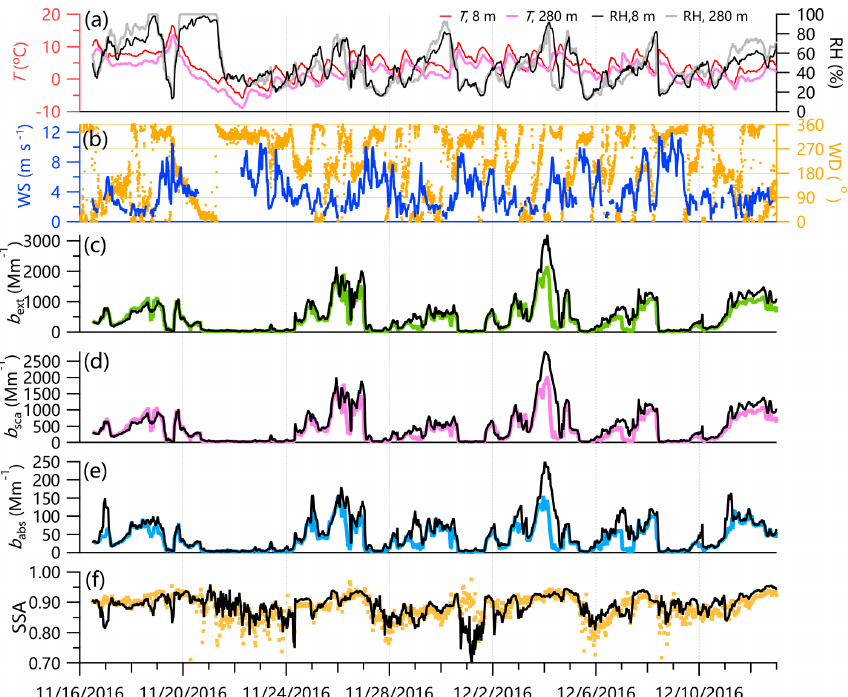
Figure 3. Temporal variations of (a) temperature ( T ) and relative humidity (RH) at ground level and 280m, (b) wind speed (WS) and wind direction (WD) at 280m, and comparisons of the time series of optical properties of PM 2 . 5 between ground level (black lines) and 260m (colored lines): (c) b ext , (d) scattering coefficient, (e) absorption coefficient, (f)